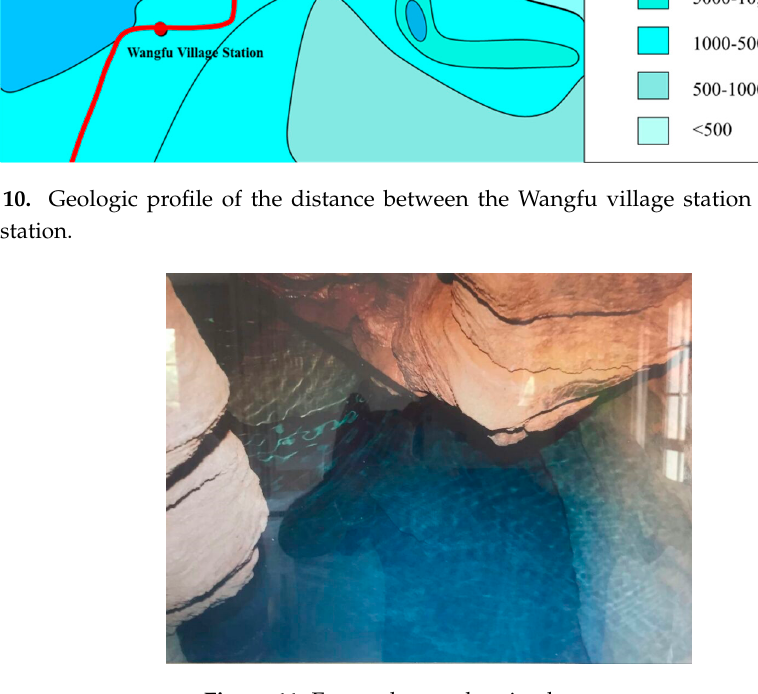
Table 1. The characteristics of different geophysical methods.